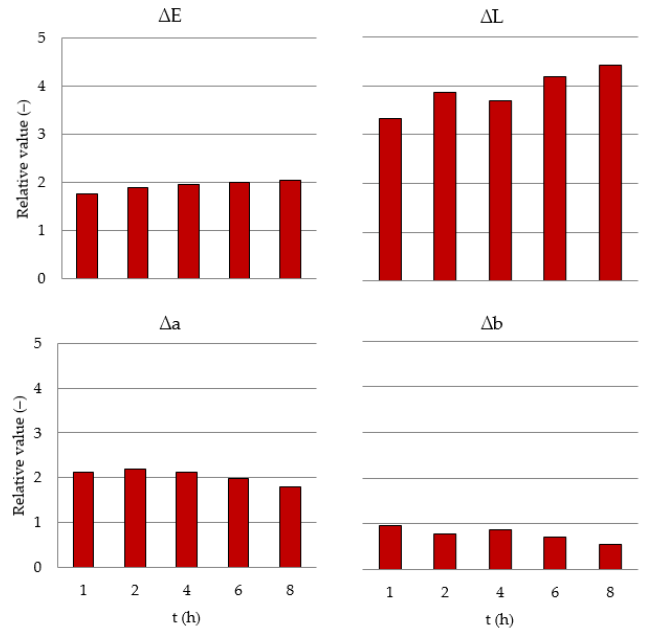
Figure 2. Relation to controlled value (in proportion) versus t (h).